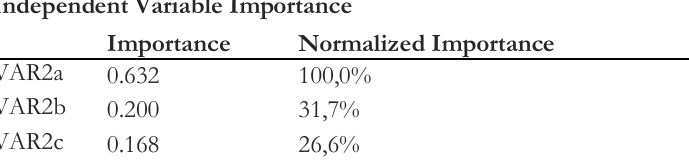
Table 5. Independent variable importance for classical item 2 in terms of neutrosophic